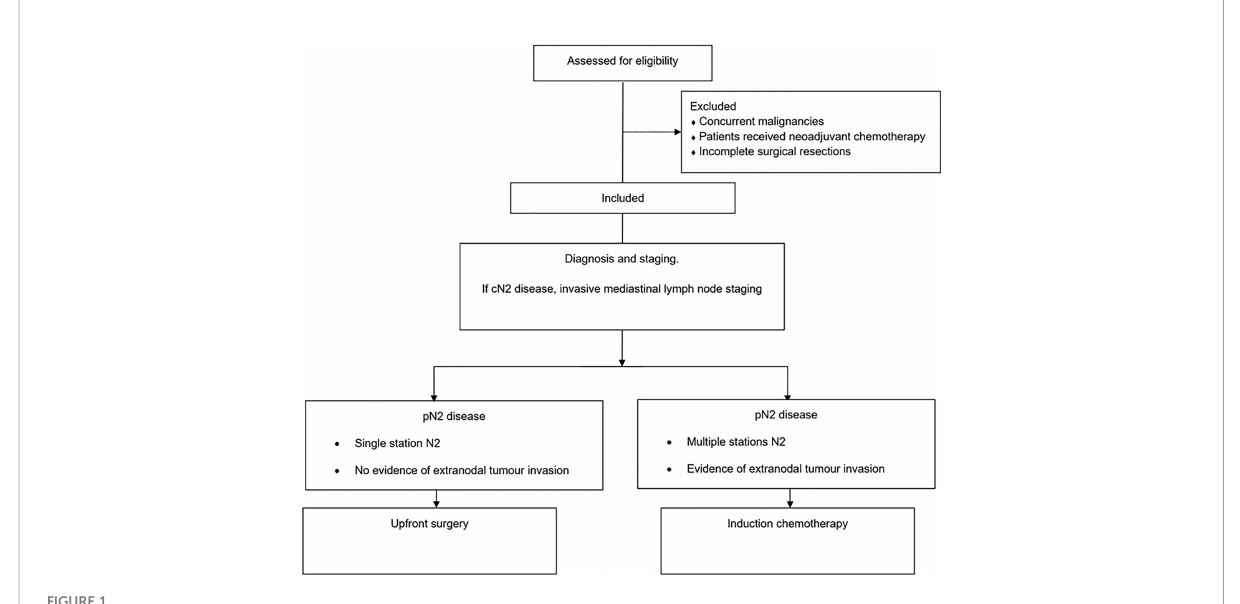
FIGURE 1 Flowchart with the study